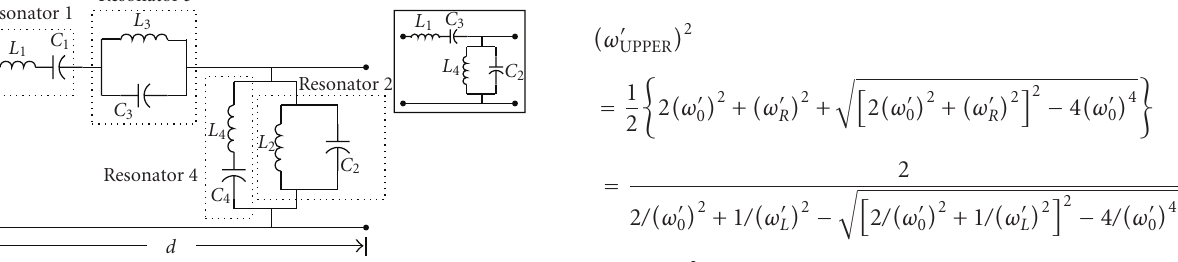
Figure 1: A lumped-element model unit cell of an extended CRLH transmission line. { d is the length of the unit cell. L 1 , L 2 , L 3 , and L 4 are the inductances in henries/m. C 1 , C 2 , C 3 , and C 4 are the capacitances in farads/m.